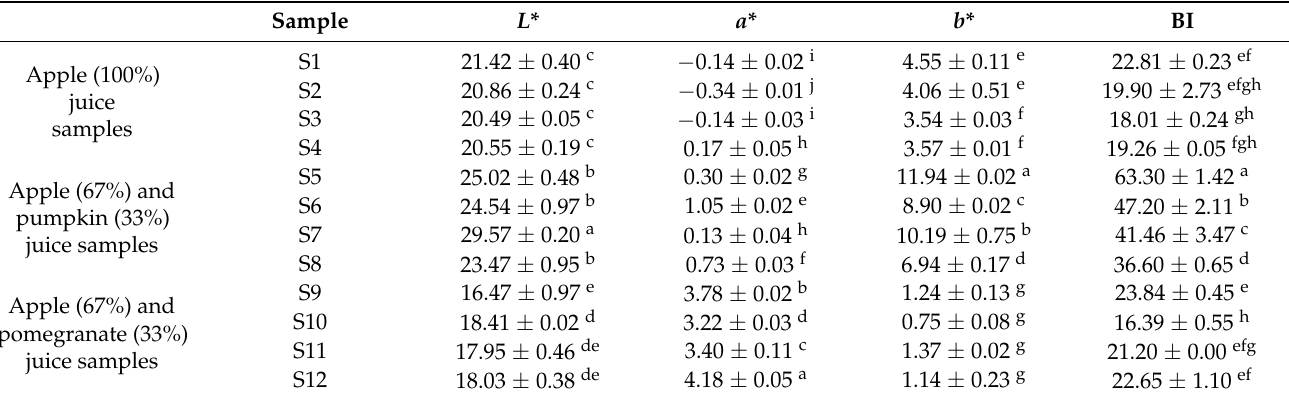
Table 4. Color parameters of initial juice